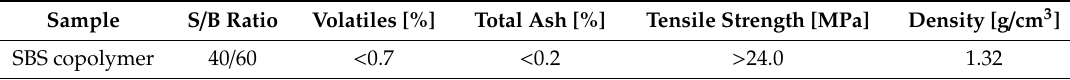
Table 2. Fundamental properties of 90-grade heavy traffic asphalt.